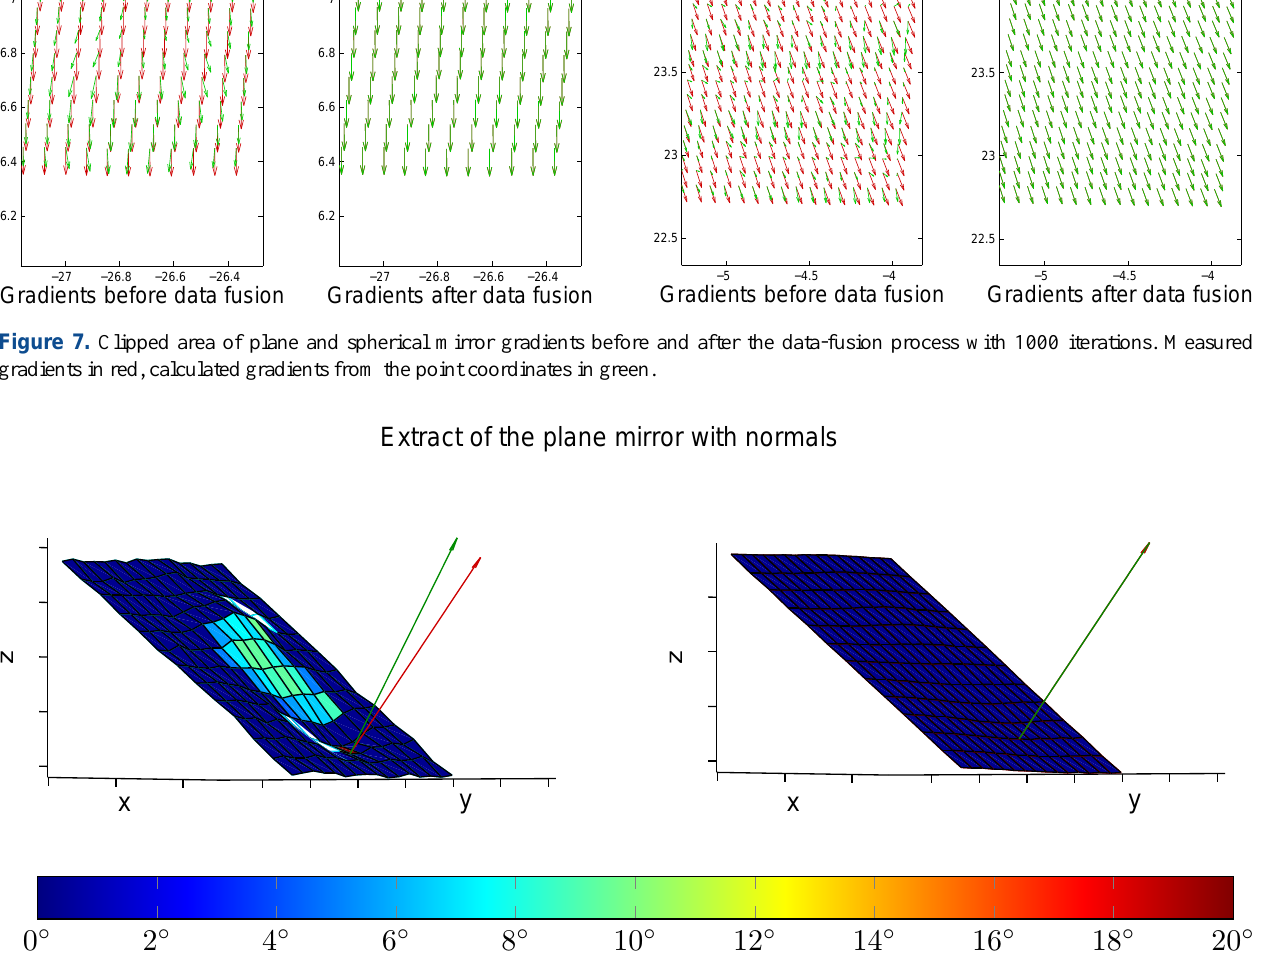
Figure 8. Left: measured point coordinates. Right: point coordinates after optimization. The red vector is a measured normal, the green a calculated normal. The color encodes the error between calculated normals and measured normals in